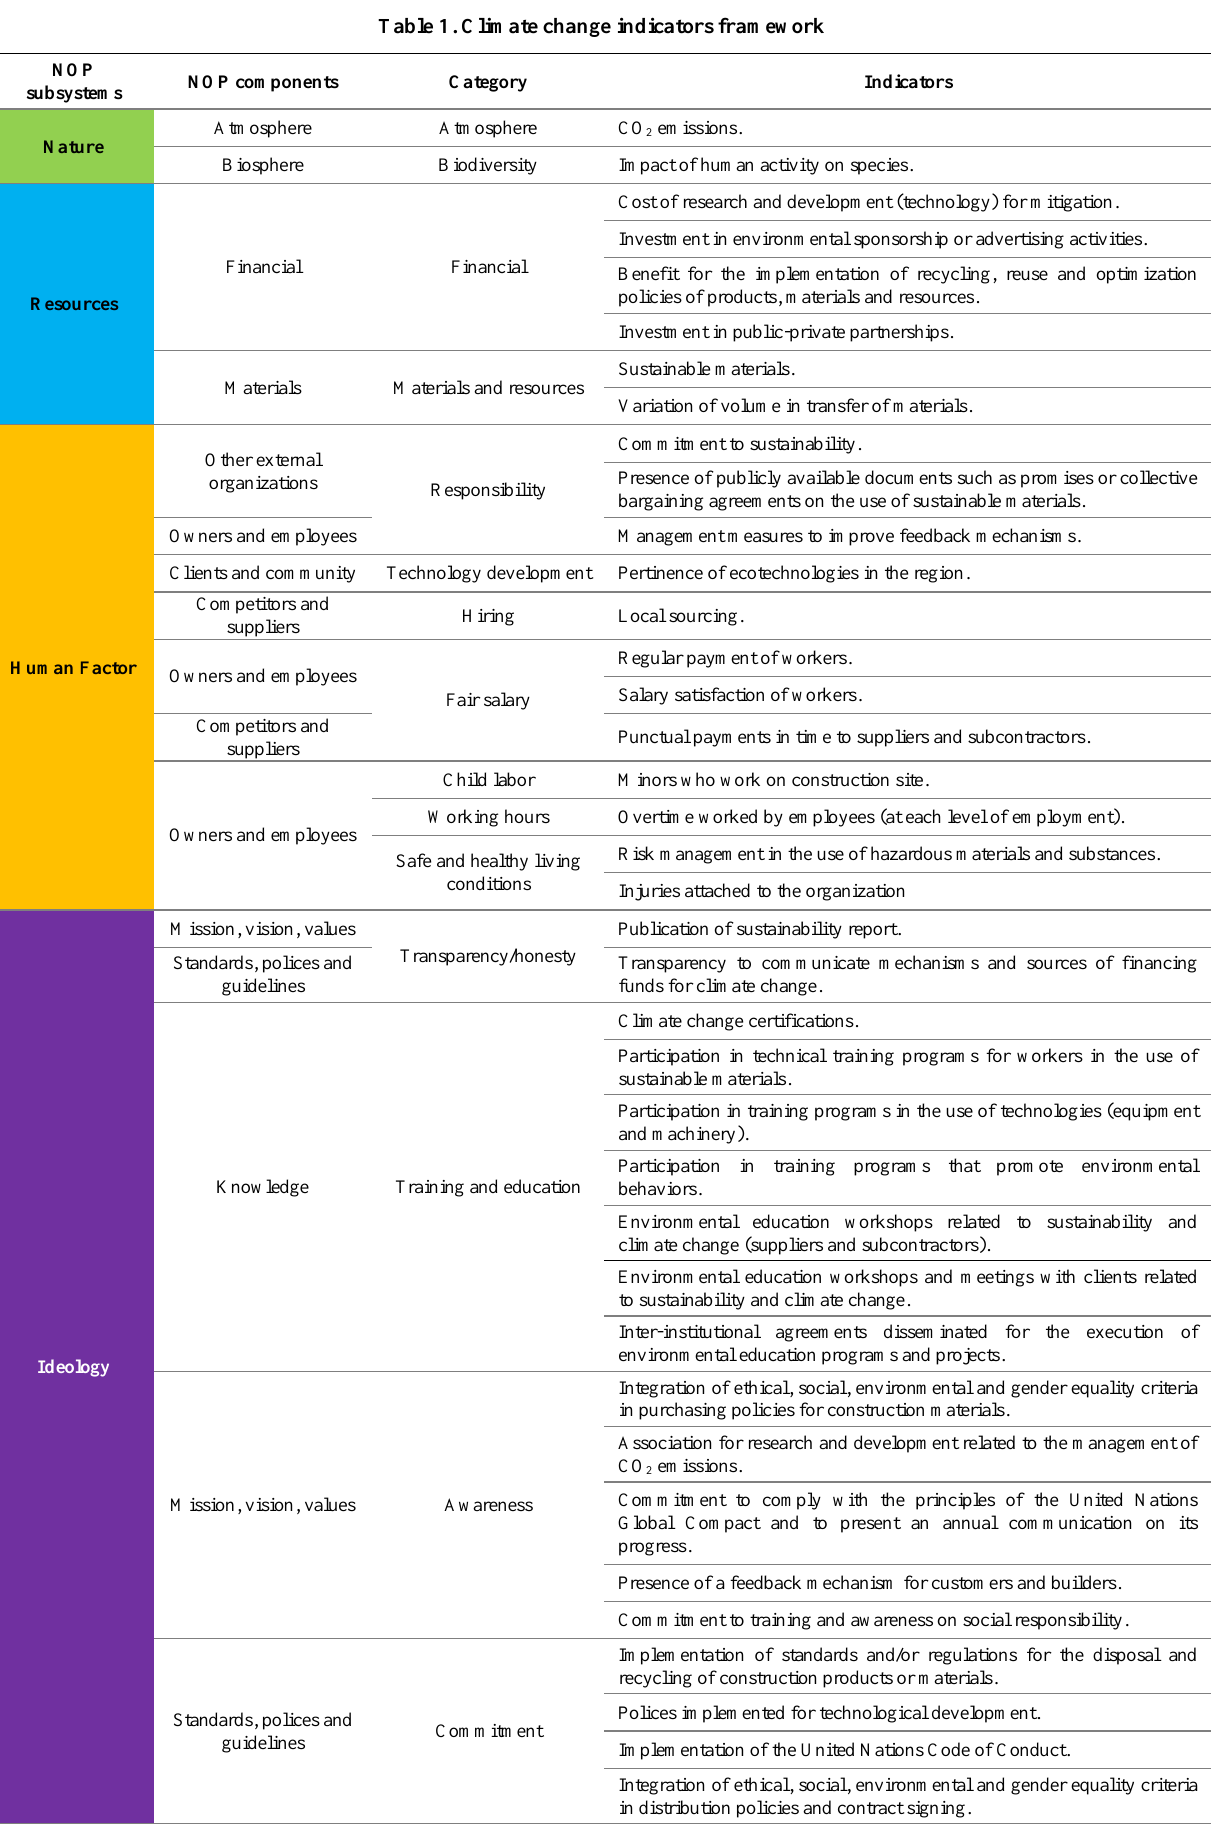
Table 1. Climate change indicators